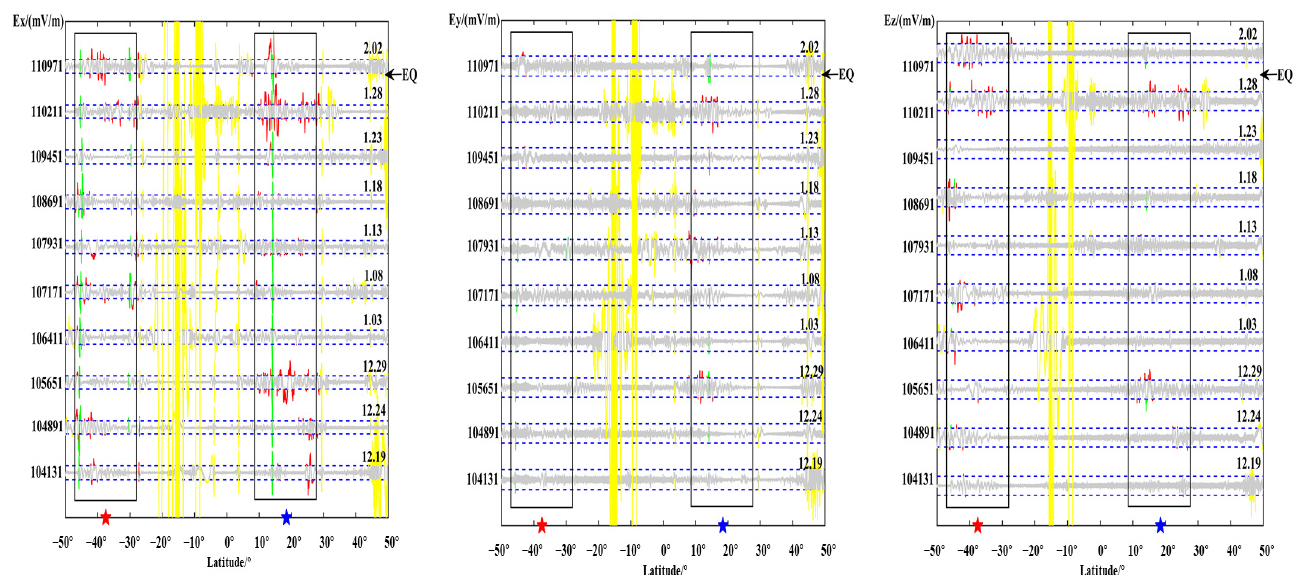
Figure 11. Orbit 110 , 211 and its revisited tracks.